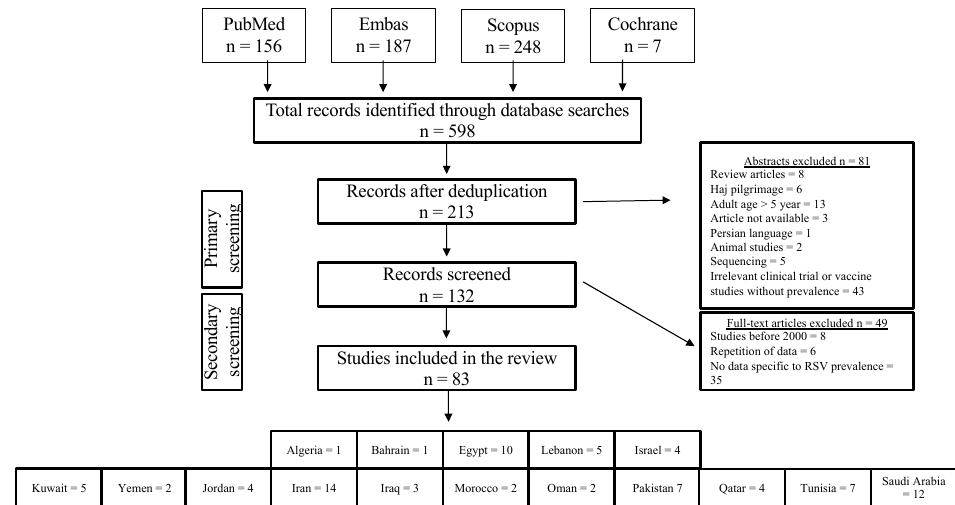
Figure 1. Flowchart of literature search and studies selection. n: number.